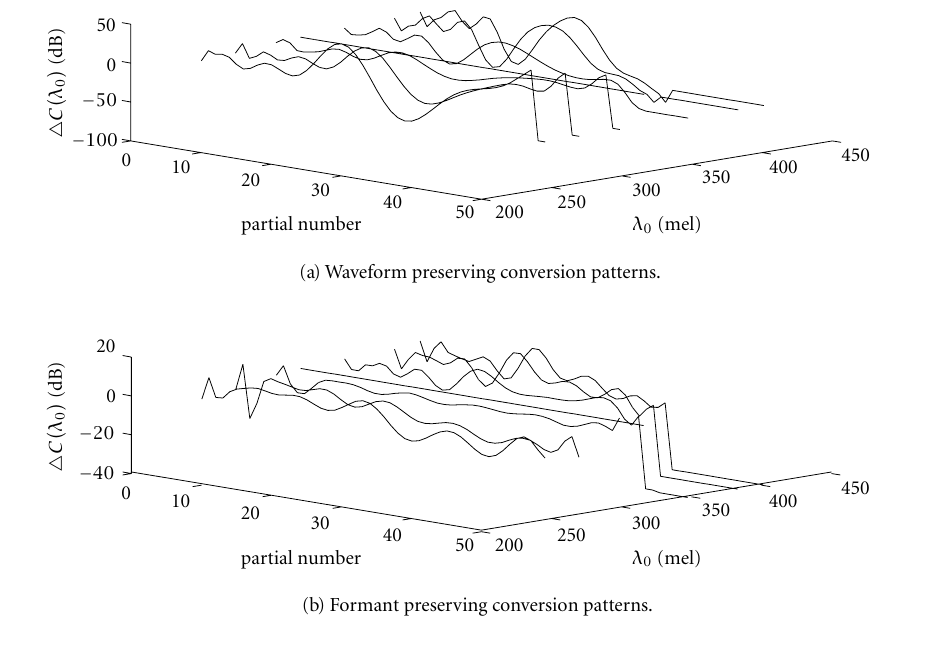
Figure 4: Conversion patterns generated from 7 voiced notes performing the same vowel: comparison between the waveform preserving procedure and the formant preserving